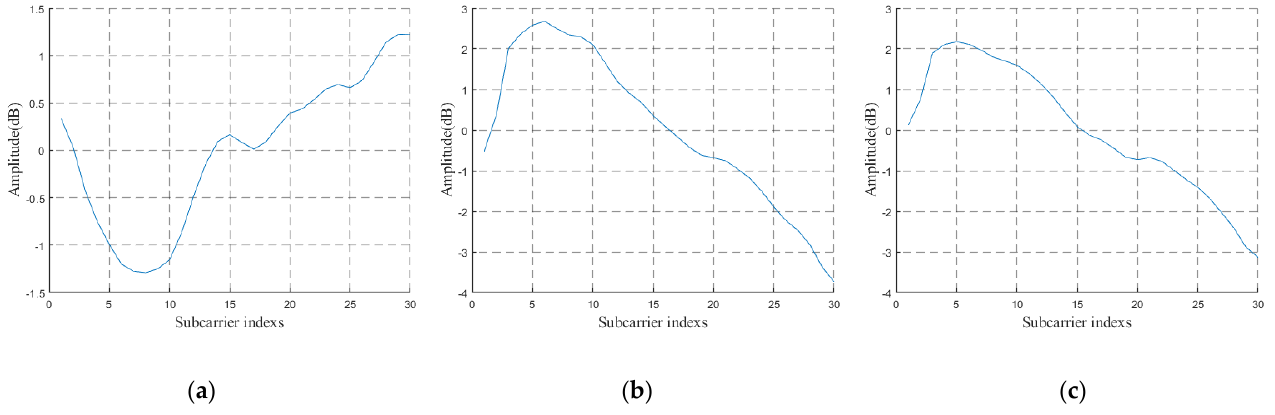
Figure 10. Preprocessed CSI signals of different people doing POSE THREE in Figure 1. ( a ) Experi- menter A-POSE THREE; ( b ) experimenter B-POSE THREE; ( c ) experimenter C-POSE THREE .